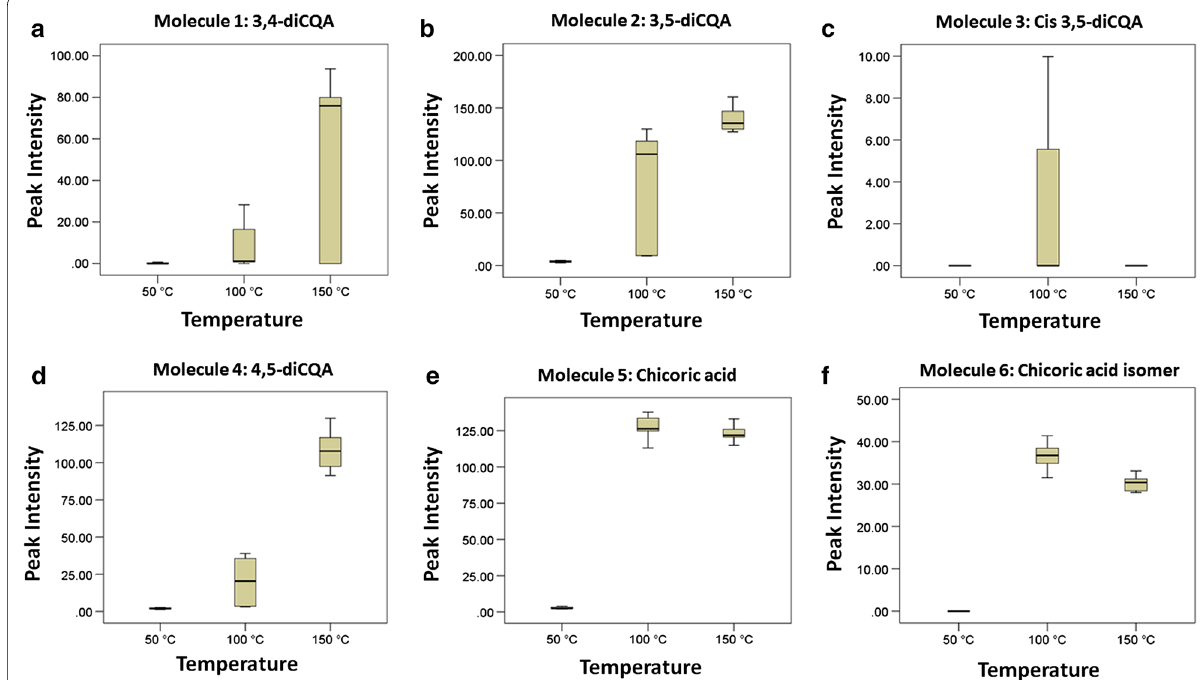
Values represent means of triplicate extraction yield SEM (standard error of the mean). Values within the same column followed by different superscripts are ± significantly different (p < 0.05). Level of significance *** p < 0.001, and ** p < 0.01. Values in italics (within a column ) represent the highest extraction yields for the molecule T 50 C 0 —extraction at 50 °C and 0 % methanol; T 50 C 20 —extraction at 50 °C and 20 % methanol; T 50 C 40 —extraction at 50 °C and 40 % methanol; T 50 C 60 —extraction at 50 °C and 60 % methanol; T 100 C 0 —extraction at 100 °C and 0 % methanol; T 100 C 20 —extraction at 100 °C and 20 % methanol; T 100 C 40 —extraction at 50 °C and 40 % methanol; T 100 C 60 —extraction at 50 °C and 60 % methanol; T 150 C 0 —extraction at 50 °C and 0 % methanol; T 150 C 20 —extraction at 50° °C and 20 % methanol; T 150 C 40 — extraction at 50 °C and 40 % methanol; T 150 C 60 —extraction at 50 °C and 60 % methanol